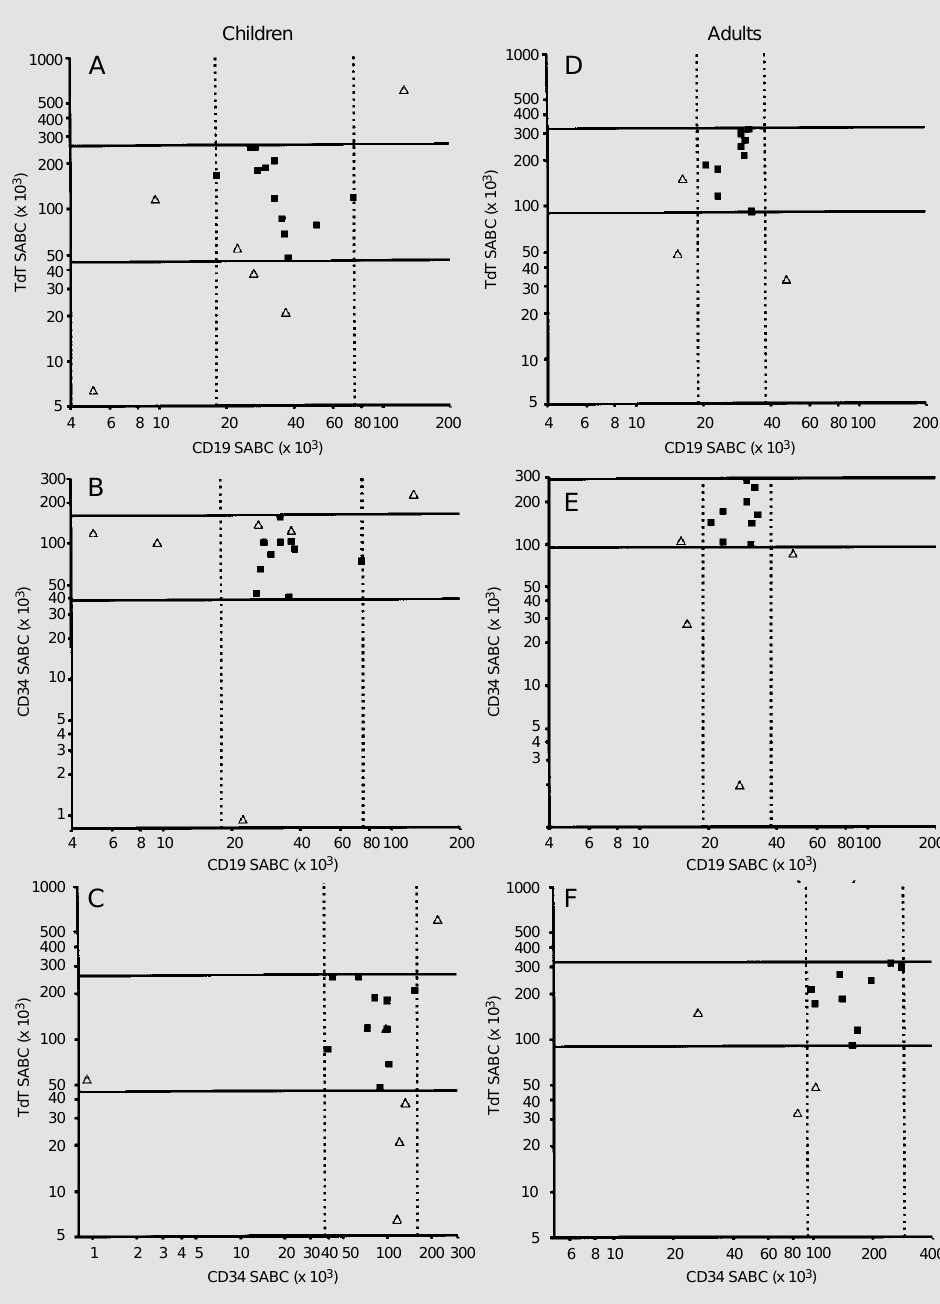
Figure 4 - Analysis of the expres- sion of the CD19 x TdT (A and D), CD19 x CD34 (B and E) and CD34 x TdT (C and F) markers in normal and leukemic children (left panel) and in normal and leukemic adults (right panel). The specific antibody binding ca- pacity (SABC) values are repre- sented in log scale. Only those patients with CD10 + acute lym- phoblastic leukemia (ALL), whose leukemic cells expressed CD10 £ 45 x 10 3 a.u. (within the normal range) are represented. The SABC values of the normal subjects are represented by filled squares and those of the CD10 + ALL cases by open tri- angles. The discontinuous lines show the cut-off values for the marker represented on the X- axis and the continuous lines represent the cut-off values for the marker on the